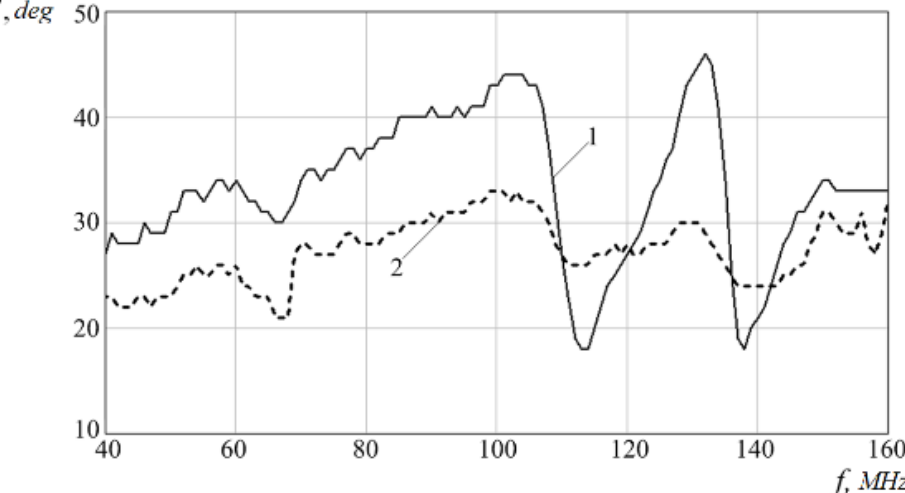
Figure 9. Experimental frequency dependences of the DOA estimates with true angle of arrival 30°. Curve 1—correlation-interferometric method; Curve 2—the VAA method.